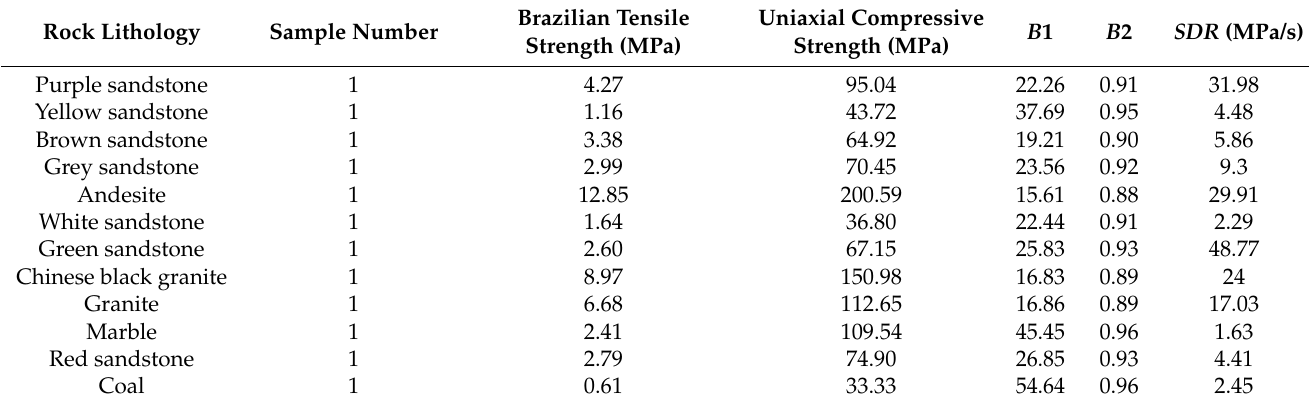
Table 5. Calculation results of B 1, B 2, and SDR .